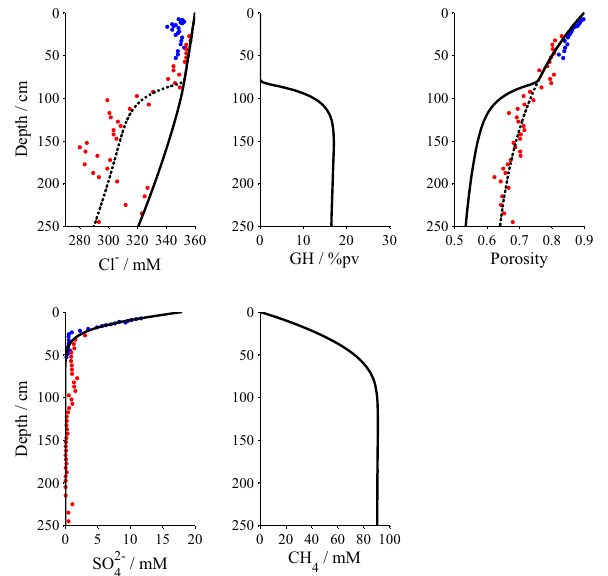
Fig. A1. Result of the numerical 1-D transport-reaction model (solid lines) of gas hydrate formation in the Batumi Seep Area at Site BS 351 DAPC. Plotted data are a combination of BS 351 DAPC (red dots) and BS 369MC (blue dots). The DAPC core probably lost ∼ 25cm sediment at the top, as inferred from the measured porosity data, whereas the multicorer liner penetrated too deep and therefore is missing the top 7cm of the sediment, as in- ferred from the sulfate data. The values of the adjusted model pa- rameters of this simulation are given in Table A1. The dotted Cl- profile would be observed ex-situ after decomposition of all model- predicted methane hydrate. The dotted porosity profile represents the initial depth distribution without hydrate formation as derived from least squares fitting to the